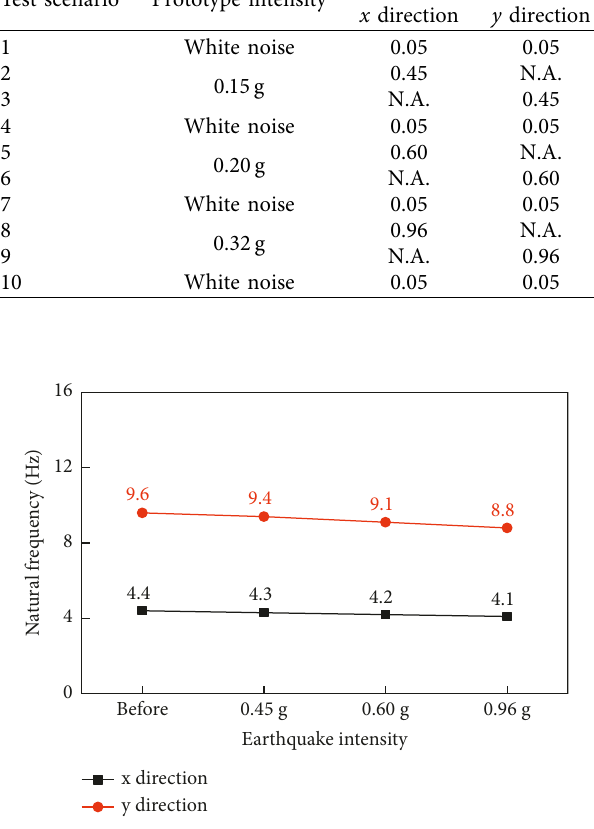
Figure 6: First natural frequency of pier specimen before and after under different experimental earthquake excitations.